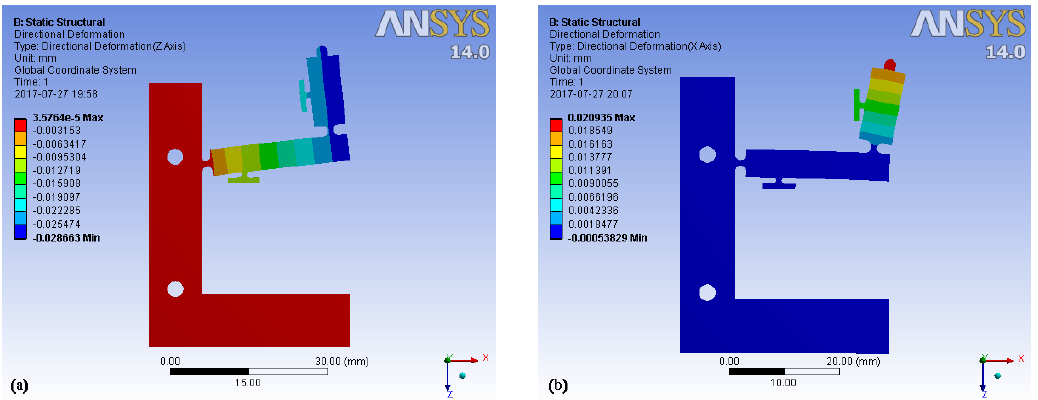
Figure 11. The magnification ratio k 1 and k 2 of the compliant lever mechanism based on the RCF. (a) Displacement diagram of k 1 ; (b) displacement diagram of k 2 .